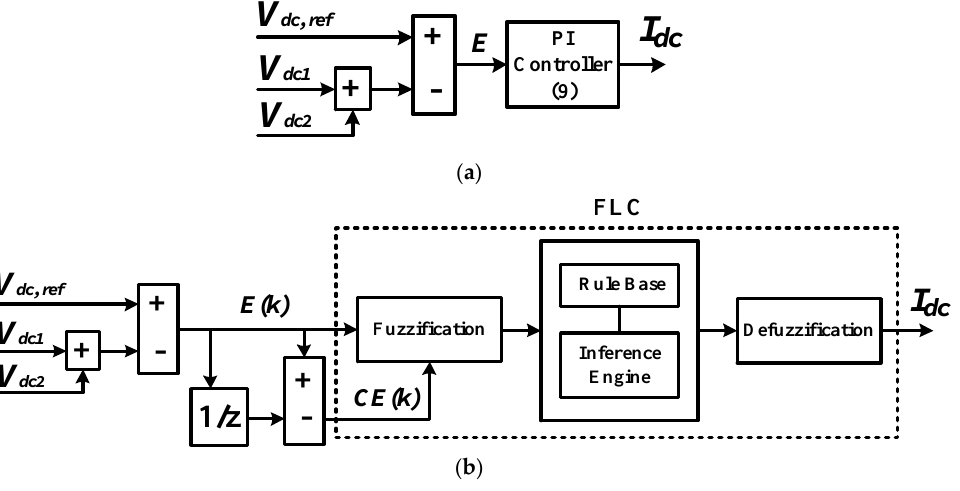
Figure 3. Conventional DC-link capacitor voltage regulation algorithm with ( a ) PI; and ( b ) FLC techniques.